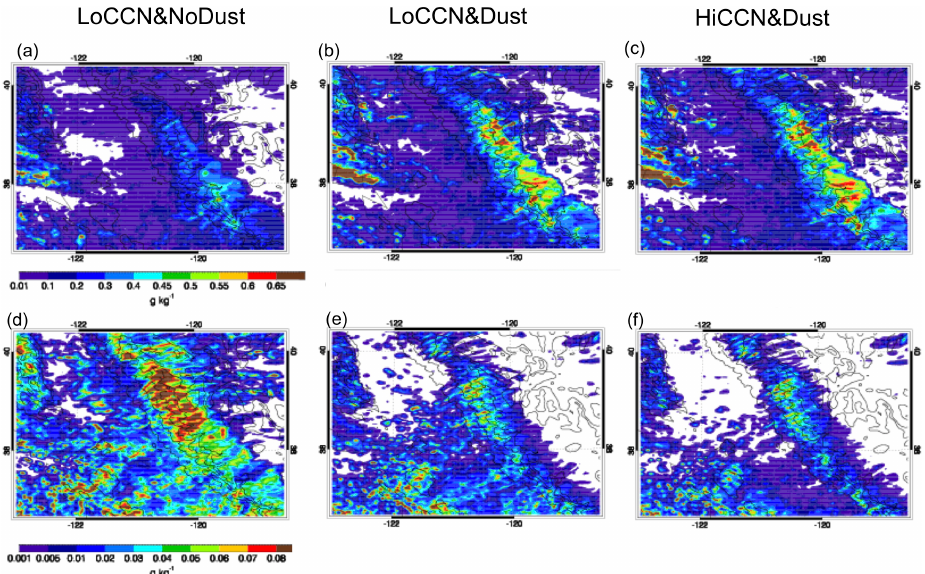
Fig. 9. Mass mixing ratios of in-cloud raindrops and snow from (a) LoCCN&NoDust, (b) LoCCN&Dust, and (c) HiCCN&Dust for FEB16. (a) , (b) , and (c) are for precipitating ice (i.e., snow+graupel but graupel content is negligible compared with snow) and (d) , (e) and (f) are for raindrops. The data are averaged over the cloudy grids (with the sum of cloud water and cloud ice >10 − 6 kgkg − 1 ) during 00:00–23:00UTC and below